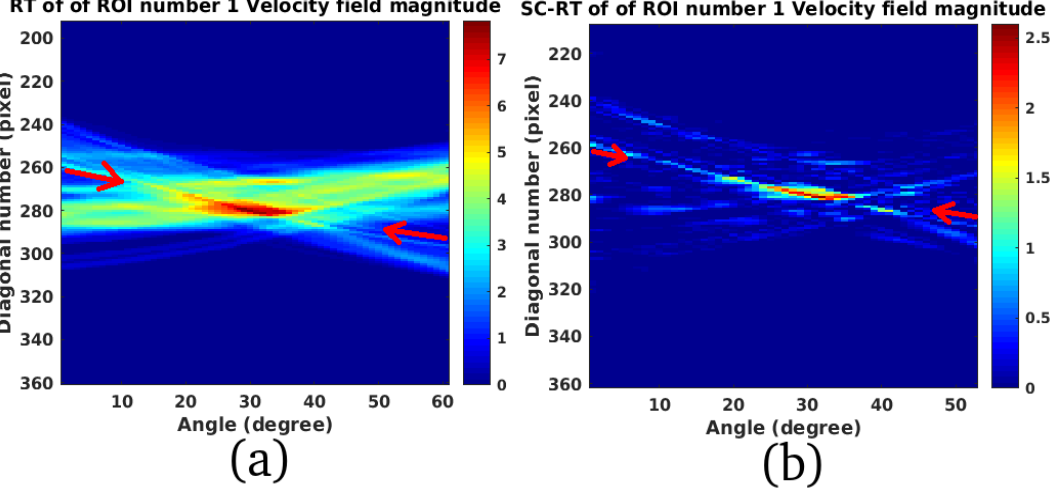
Figure 18. ( a ): RT of the displacement ROI (Particular 1 of Figure 17). ( b ): Sparse component of the RT of the displacement ROI (Particular 4 of Figure 17).